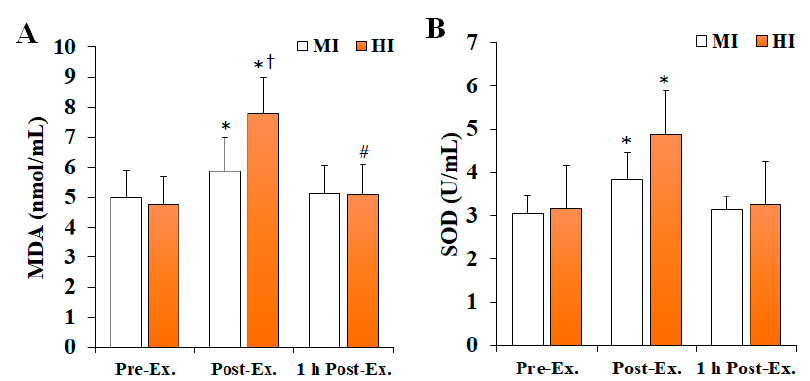
Figure 1. The changes in OS markers after treadmill running at different exercise intensities. Values are presented as mean ± SD. ( A ) MDA: malonaldehyde, ( B ) SOD: superoxide dismutase, MI: moderate-intensity, HI: high-intensity, Ex: exercise, * significant difference with pre-exercise and 1 h post-exercise within group ( p < 0.05), # significant difference with pre-exercise within group ( p < 0.05), † significant difference with MI group within time ( p < 0.05).